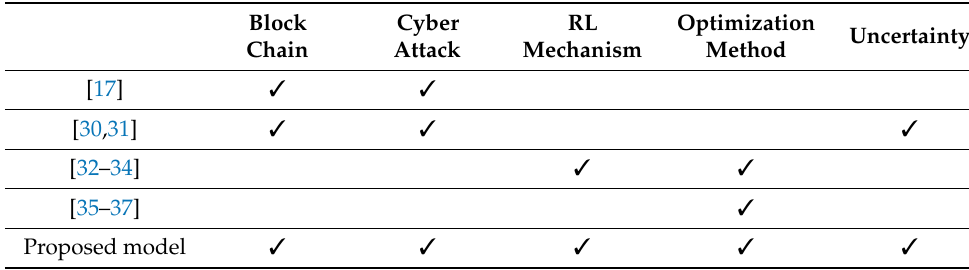
Table 1. Categorization of the different approaches. Block